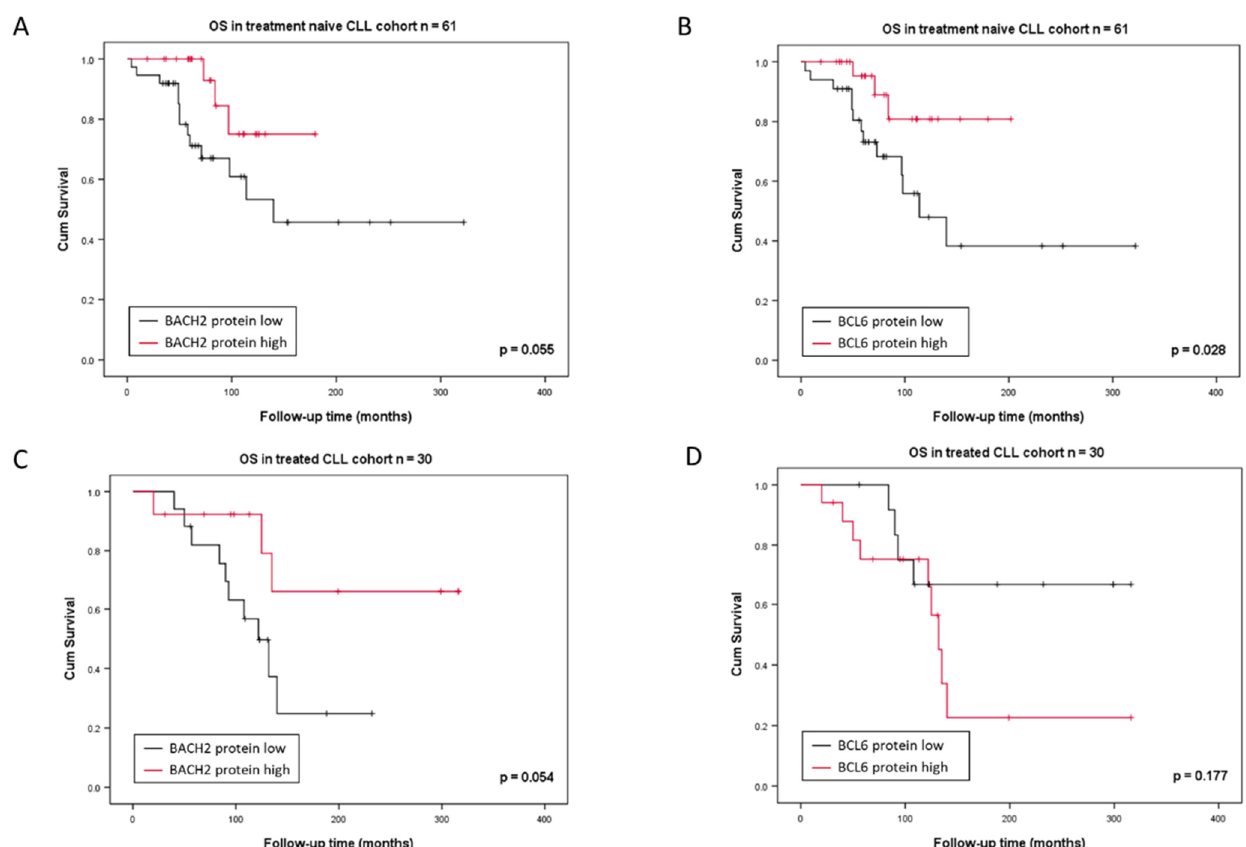
Figure 5. Survival analyses based on treatment status within the high and low protein expressing groups of BACH2 and BCL6: ( A ) BACH2 expression of treatment naïve arm, ( B ) BCL6 expression of treatment naïve arm, ( C ) BACH2 expression of previously treated arm, and ( D ) BCL6 expression of previously treated arm.